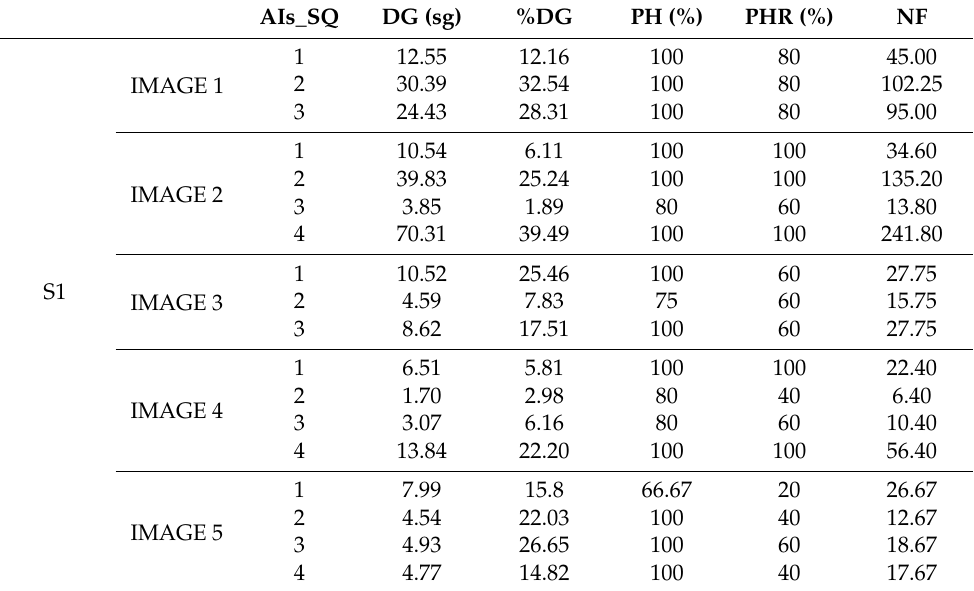
Table 1. Fixations and gaze by AI for